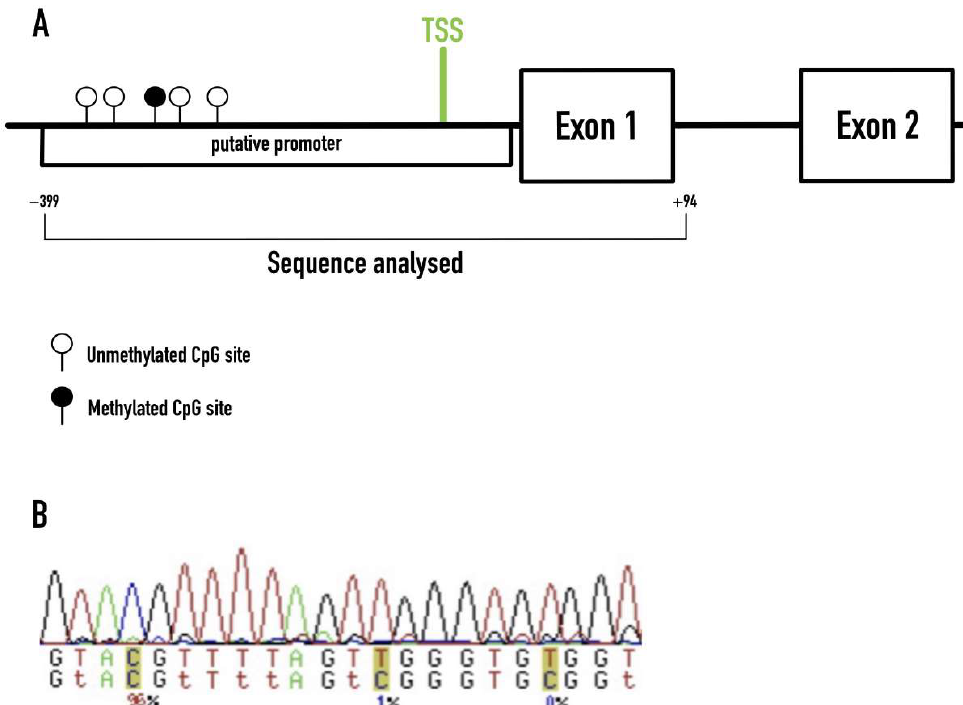
Figure 1. Methylation profiling of the RAMP1 promoter region in our cohort. ( A ) Sequence of the RAMP1 gene analyzed in this study. The methylated CpG site illustrated (black circle) refers to the −284 CpG unit found to be significantly methylated in migraineurs. TSS–Transcription Start Site. ( B ) Example of the ESME software output.